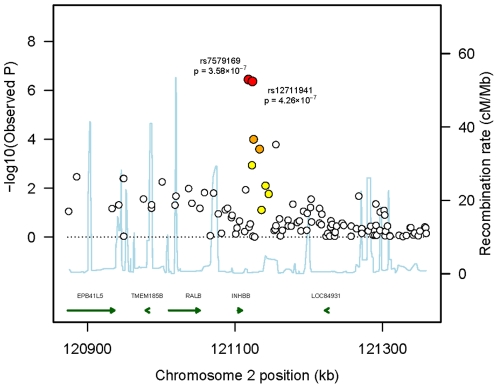
Association plot of the chromosome 2 region reaching genome-wide significance with preeclampsia susceptibility (rs7579169±250 kb).Observed p-values are plotted as −log10 values as a function of the SNPs physical location (NCBI Build 37.2). Estimated recombination rates were extracted from HapMap data. The local linkage disequilibrium structure is based on the observed allele frequency data in the Australian cohort (red dots, r2≥0.8; orange dots, 0.5≤r2<0.8; yellow dots, 0.2≤r2<0.5; clear dots, r2<0.2). Gene annotations were obtained from the UCSC genome browser (Human, Feb. 2009 [GRCh37/hg19]).